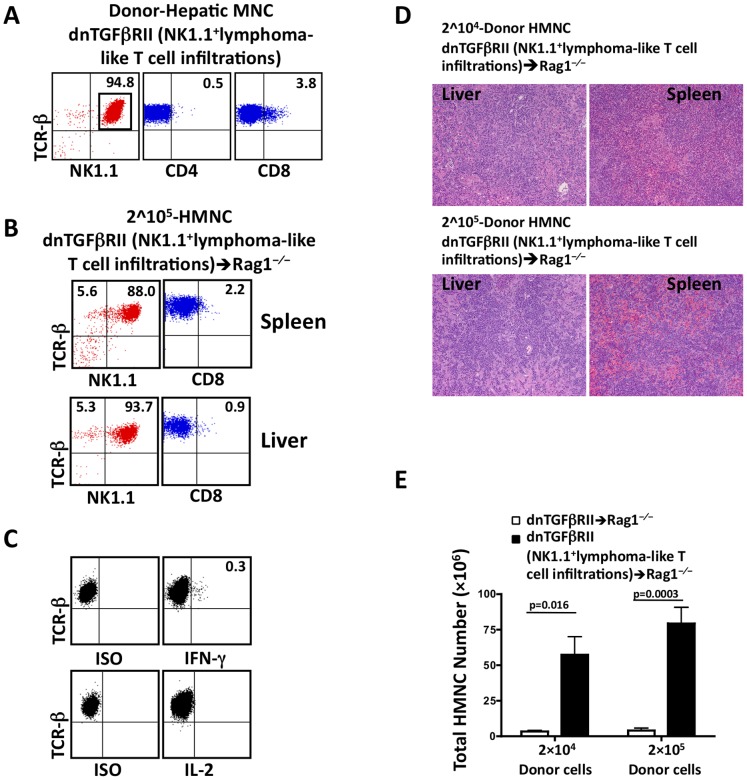
Lymphoma-like T cell infiltration is transplantable into Rag1−/− mice.A. Flow cytometric analysis of HMNCs from donor mouse showing a TCRβ+NK1.1+CD4−CD8− phenotype. B. Representative flow cytometric analysis of splenic and hepatic MNCs from recipient mice 6 weeks post-transfer. C, Intracellular IFN-γ and IL-2 production. D. H&E stained spleen and liver sections from Rag1−/− recipient mice 6 weeks post-transfer of 2×104 or 2×105 HMNCs from inbred dnTGFβRII mice with lymphomatous lesions. E. Total HMNCs in Ly5.1Rag1−/− recipient mice six weeks post-transfer. Ly5.1Rag1−/− mice were adoptively transferred with 2×104 or 2×105 hepatic mononuclear cells from inbred dnTGFβRII mice with (n = 4) or without (n = 3) lymphomatous lesions, respectively.